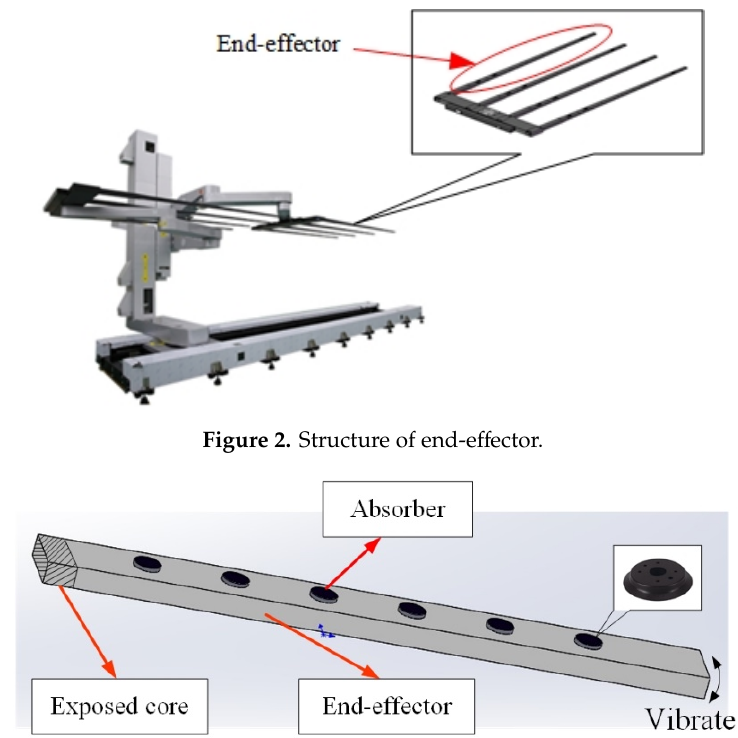
Figure 3. The model of end-effector.